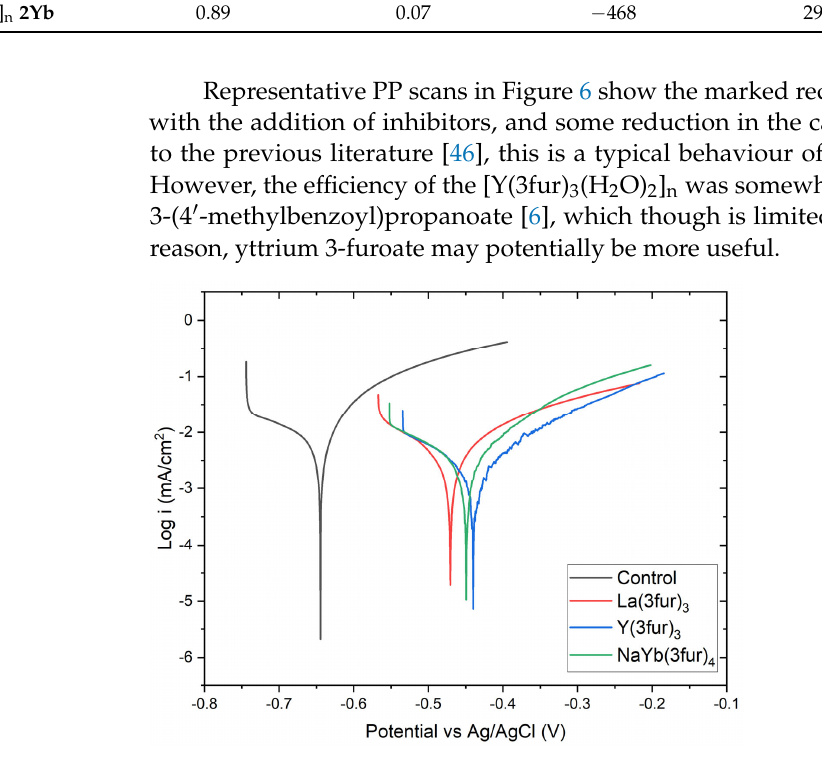
Table 3. Summary of corrosion parameters obtained from potentiodynamic polarisation tests in control and inhibited solutions after 24 h immersion. i corr Std. Dev. Solution ( μ A/cm 2 )